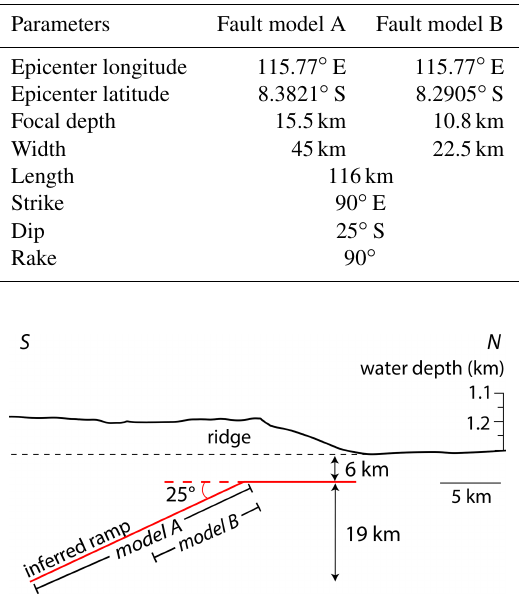
Table 1. Parameters of fault models A and B used in the numerical modeling.